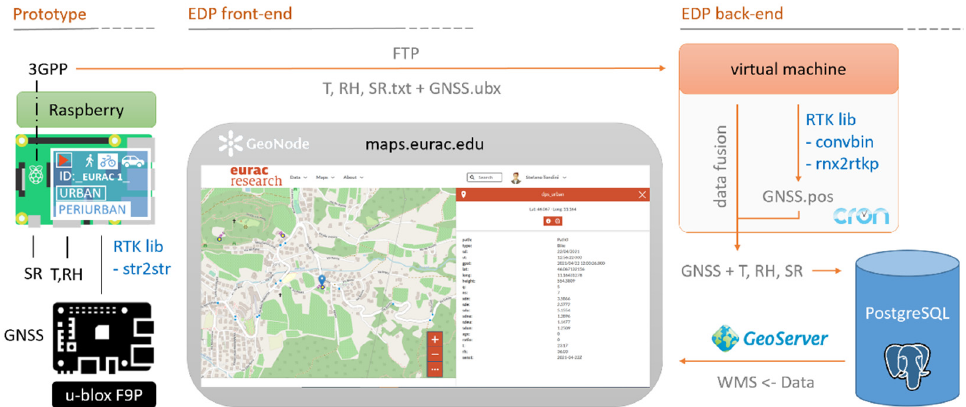
Figure 5. Automatized data acquisition workflow exploited in the mobile monitoring approach. The schematic is split into its three main components: the hardware prototype on the left, the EDP front- end in the middle, and the EPD back-end on the right. The EDP front-end is the access point for the end-users who are interested in the visualization/processing of the data collected during the field campaigns.